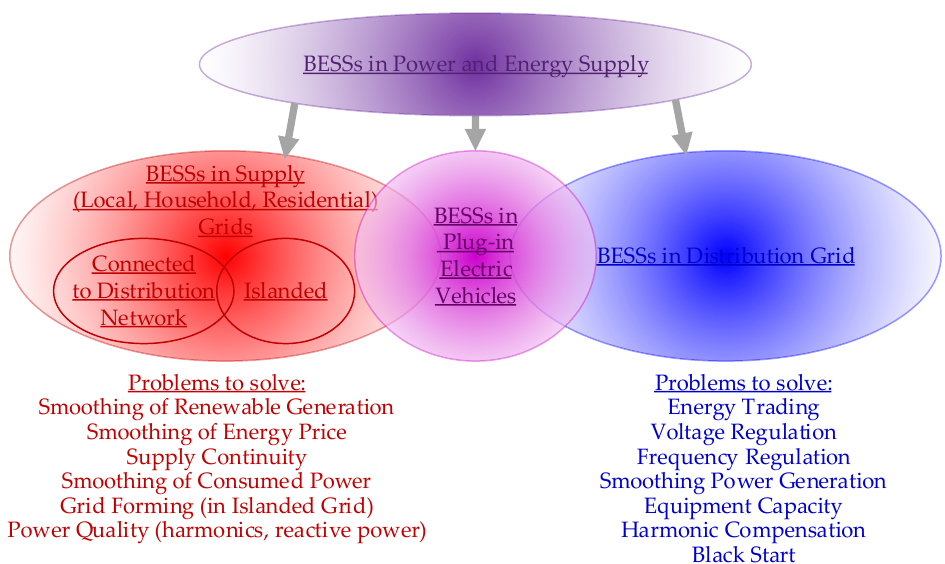
Figure 3. Battery Energy Storage Systems (BESSs) in power and energy supply at a glance.